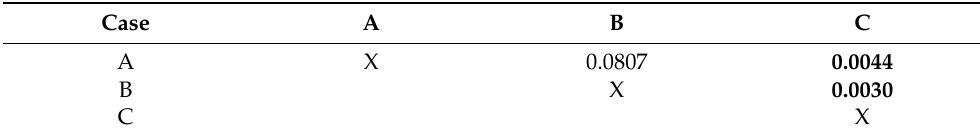
Table 9. The p -values from three retrofitting measures—(A) Case 1, (B) Case 2, and (C) Case 3— evaluated using the ReCiPe 2016 endpoint single-score